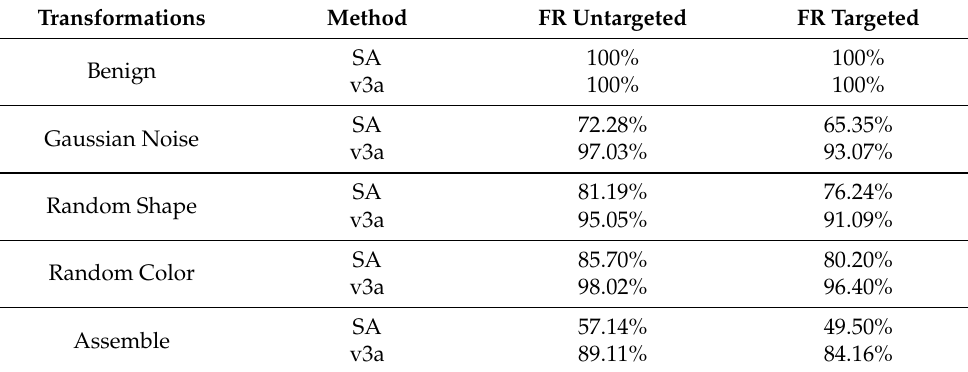
Table 1. White-box attacks against the LRCN model. The MAP of SA and our method are 0.0125 and 0.0133, respectively.